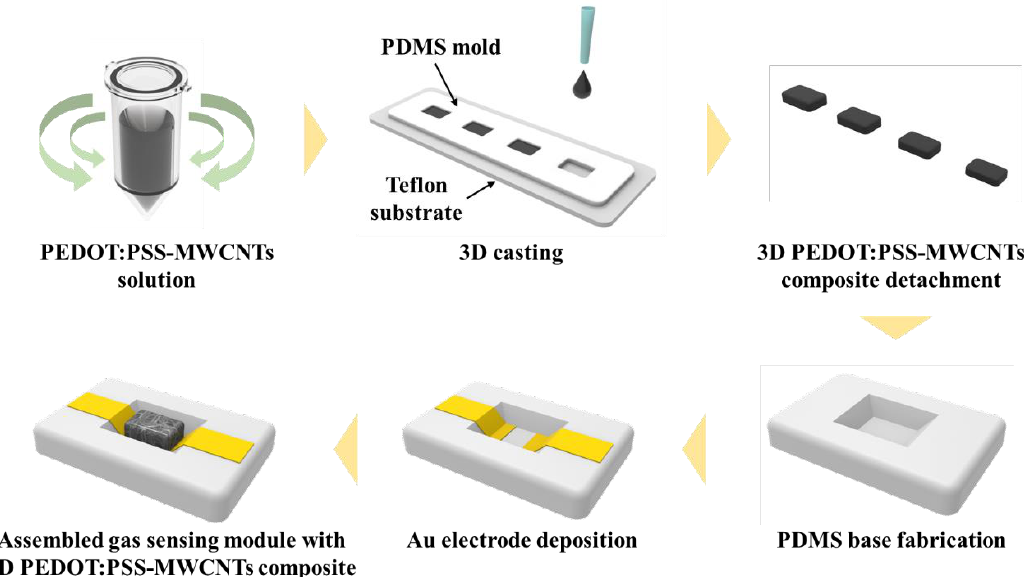
Figure 2. Fabrication process for the gas-sensing module using conductive 3D PEDOT:PSS-MWCNT